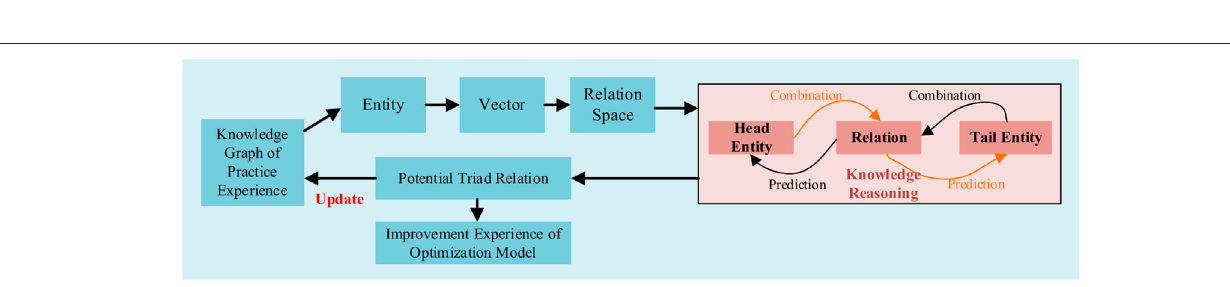
FIGURE 7 | Optimization of model improvement experience assisted by the knowledge